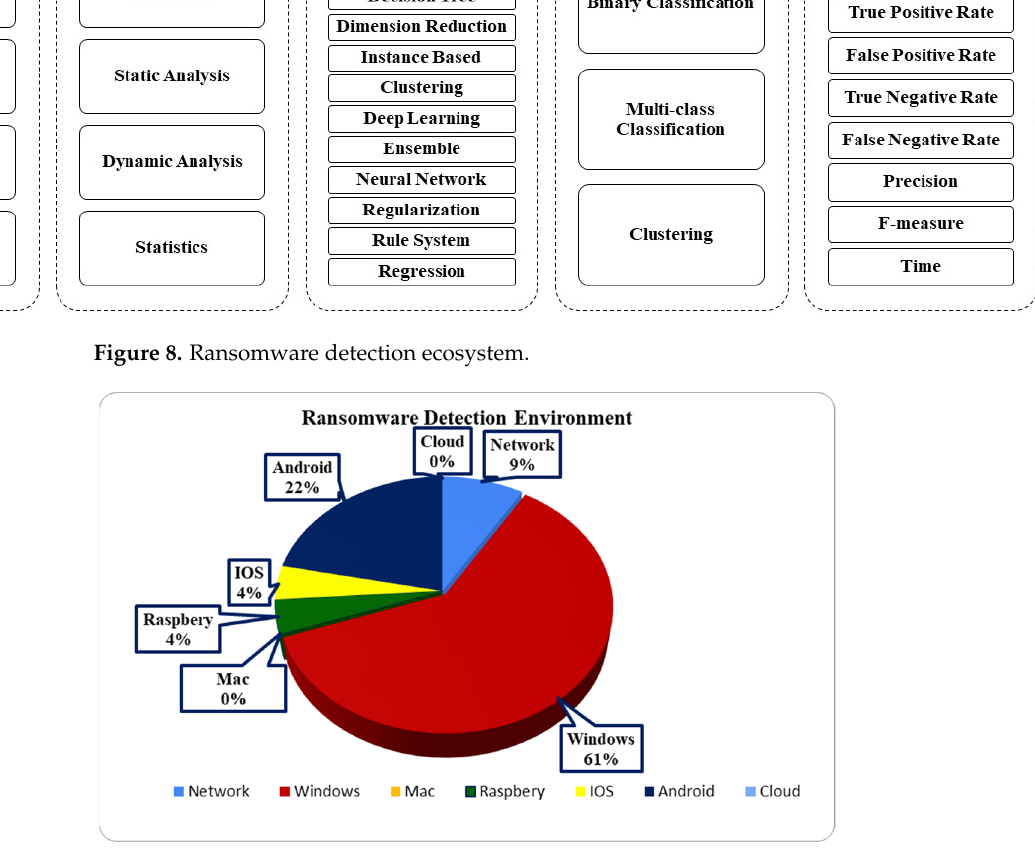
Figure 9. Different ransomware detection environments.